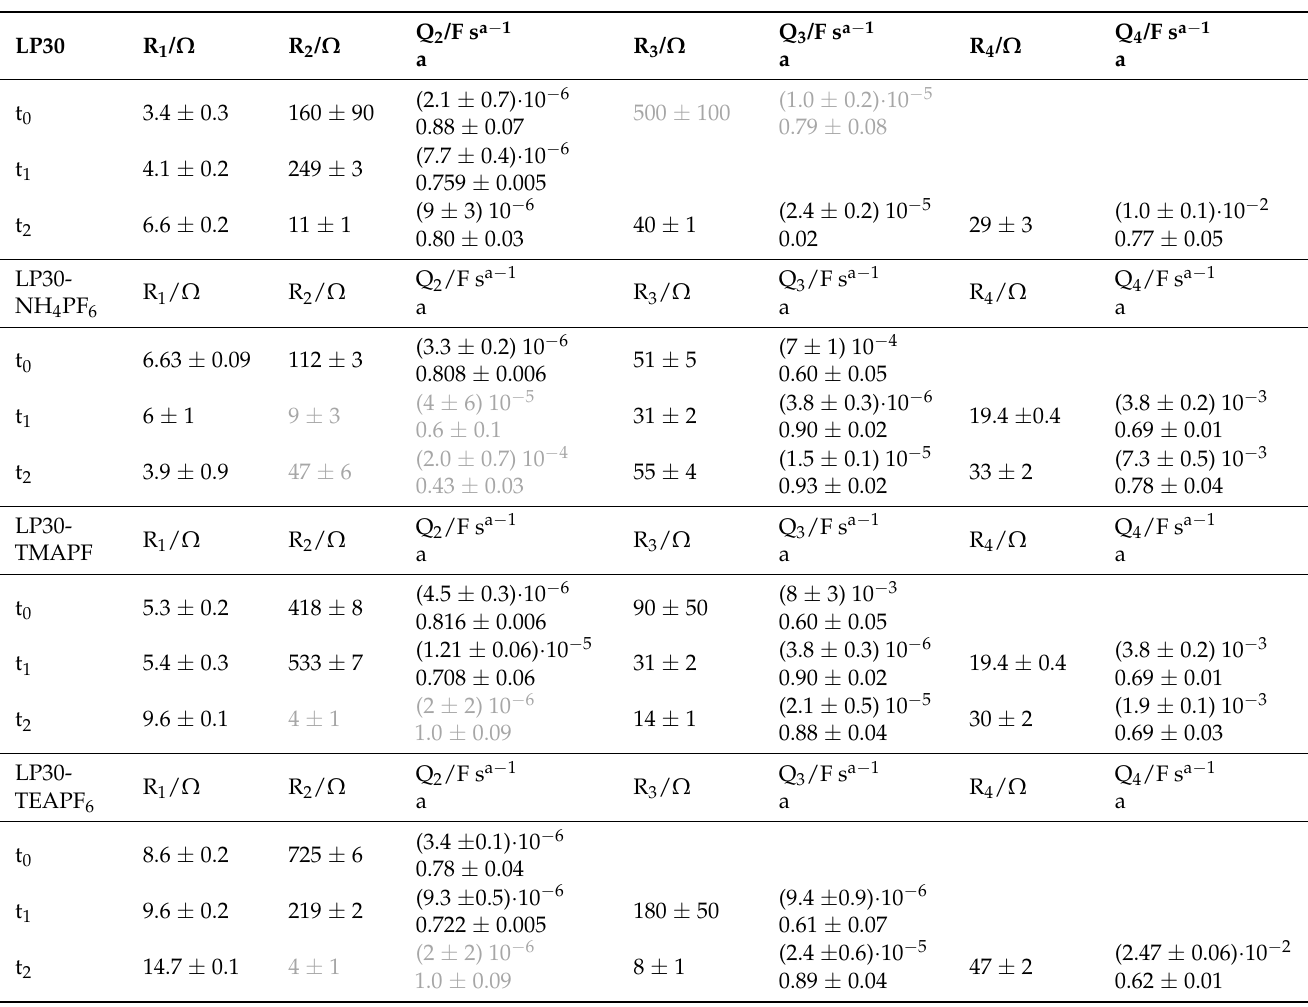
Table A2. Fitting parameters of the impedance spectra over deposition/stripping tests of Li||Li cells with LP30-based solutions. t 0 = before test, t 1 = after 10 cycles at 0.125 mA cm − 2 , t 2 = after